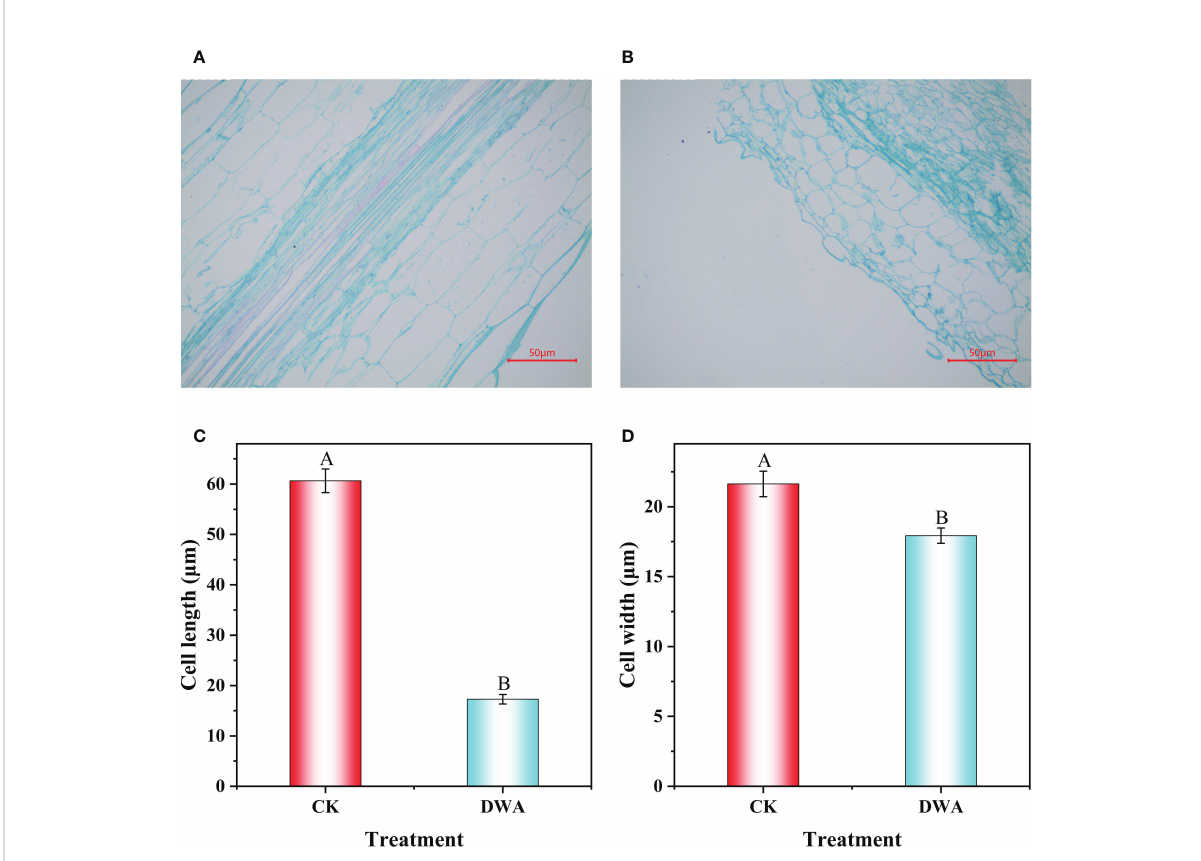
FIGURE 2 Longitudinal section and cell size of hypocotyl under uniconazole in fl owering Chinese cabbage seedlings. (A) Parenchyma cells of CK. (B) Parenchyma cells of DWA. (C) Cell length. (D) Cell width. CK, 0 mg L -1 uniconazole (pure water); DWA, 100 mg L -1 uniconazole. The vertical bars show the standard error of the mean ( n = 10). Letters above columns mean signi fi cant difference at P <